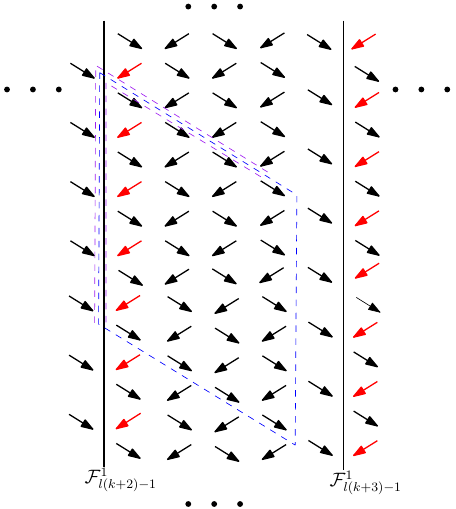
Figure 8. Region L 1 , for which it is sufficient to prove (22) consists of points M + 2 ln ≤ N ≤ M + 2 l ( n + 1 ) where l ( k + 2 ) − 1 ≤ M ≤ l ( k + 3 ) − 2. It is highlighted with blue dashed lines. Union of boundaries for all terms of the considered expression ∂ L 1 ∪ T − 1 points ( l ( k + 2 ) − 1, N ) for l ( k + 2 ) − 1 + 2 ln ≤ N ≤ l ( k + 2 ) − 1 + 2 l ( n + 2 ) and points ( l ( k + 2 ) − 1 + j , l ( k + 2 ) − 1 + 2 ln + j ) for j = 0, . . . , l − 1. It is highlighted with purple dashed lines. Here, we depict the case, where l =